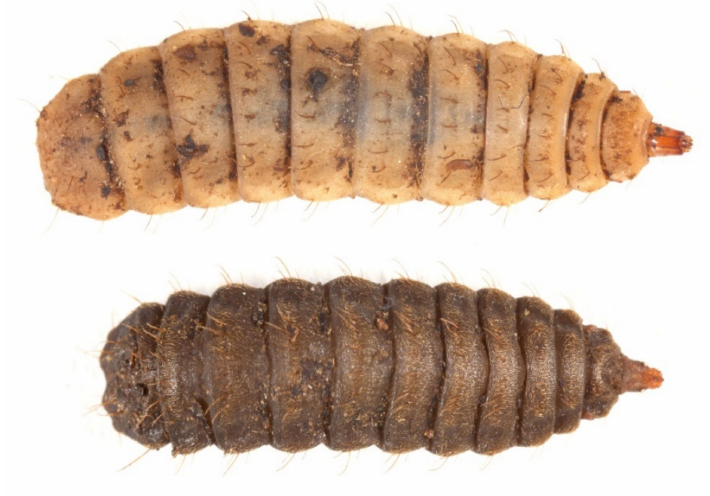
Figure 1. Larval instar classification; on the above the larval instar 6 and below prepupae. Scale bar: 1